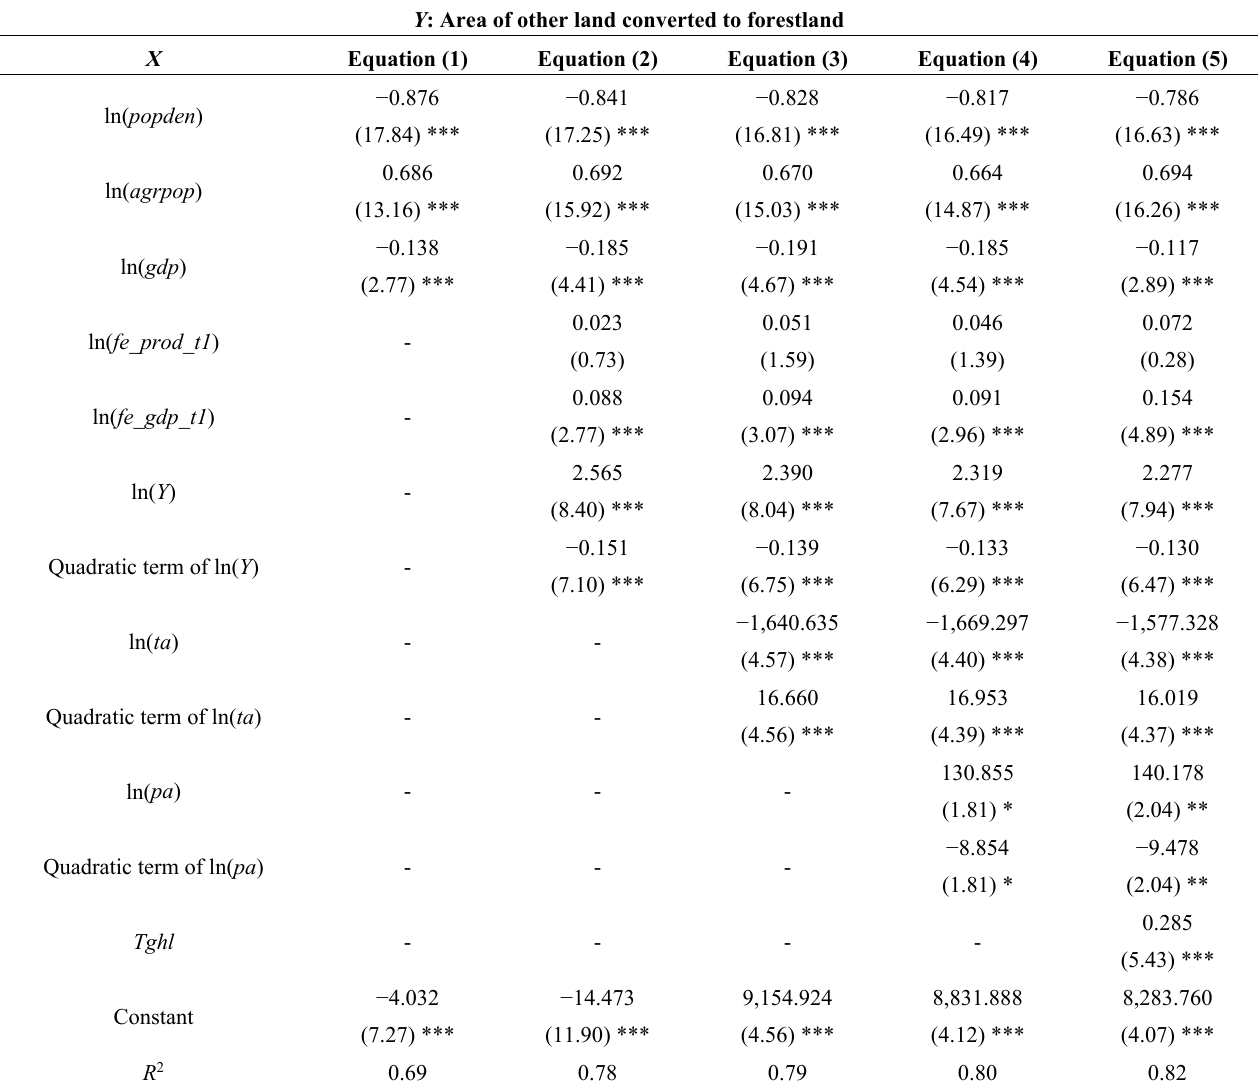
Table 3. Driving mechanism analysis of the afforestation process. Y : Area of other land converted to